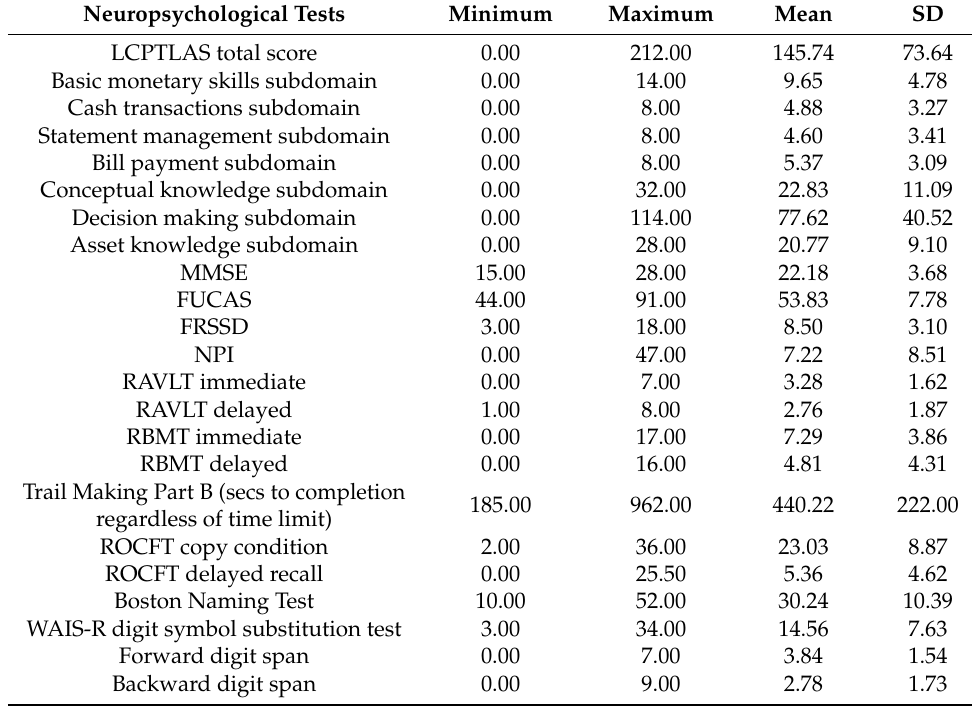
Table 2. Minimum–maximum, Mean and SDs regarding LCPTLAS total score and subscale scores. Neuropsychological